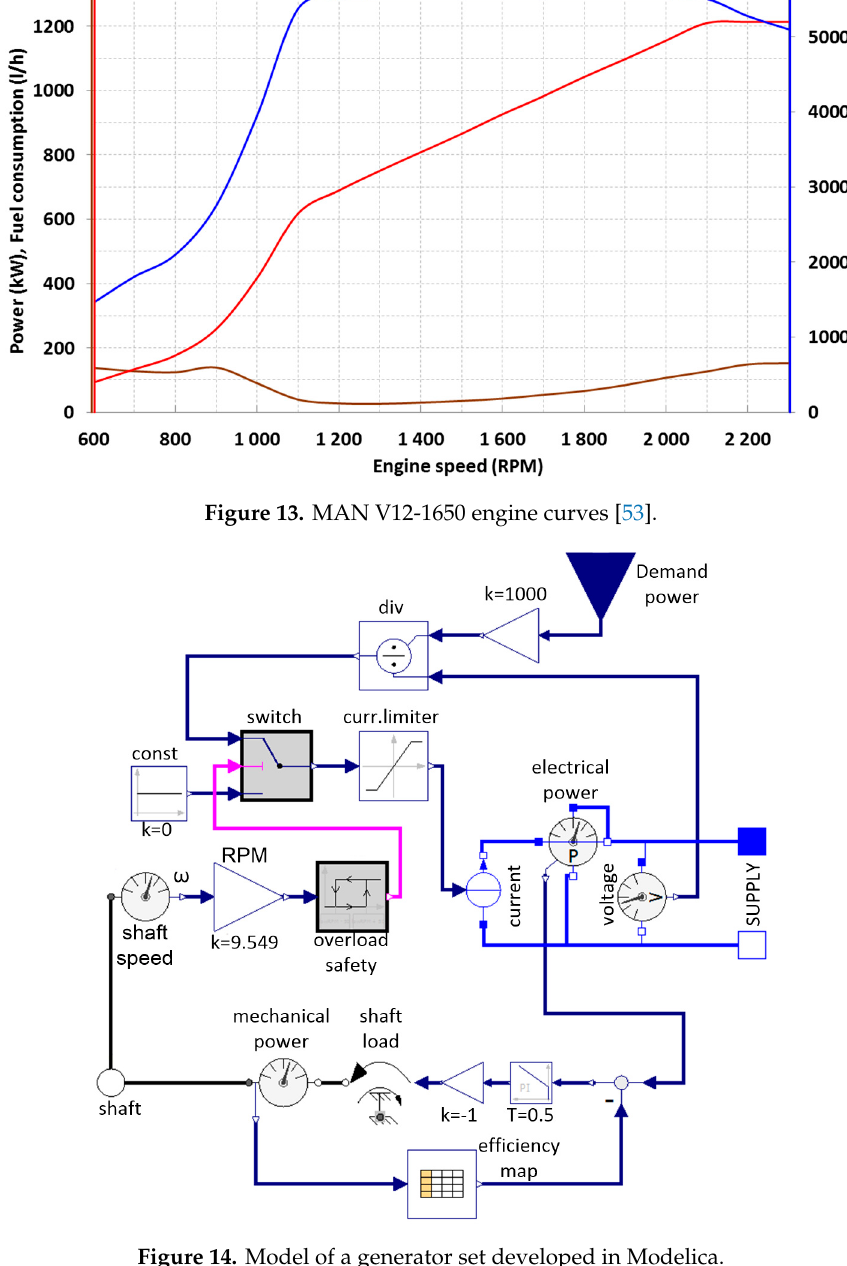
Figure 14. Model of a generator set developed in Modelica.